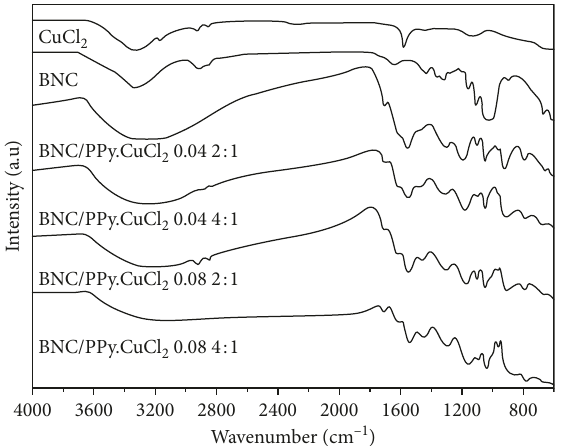
Figure 2: FT-IR spectra of BNC, CuCl